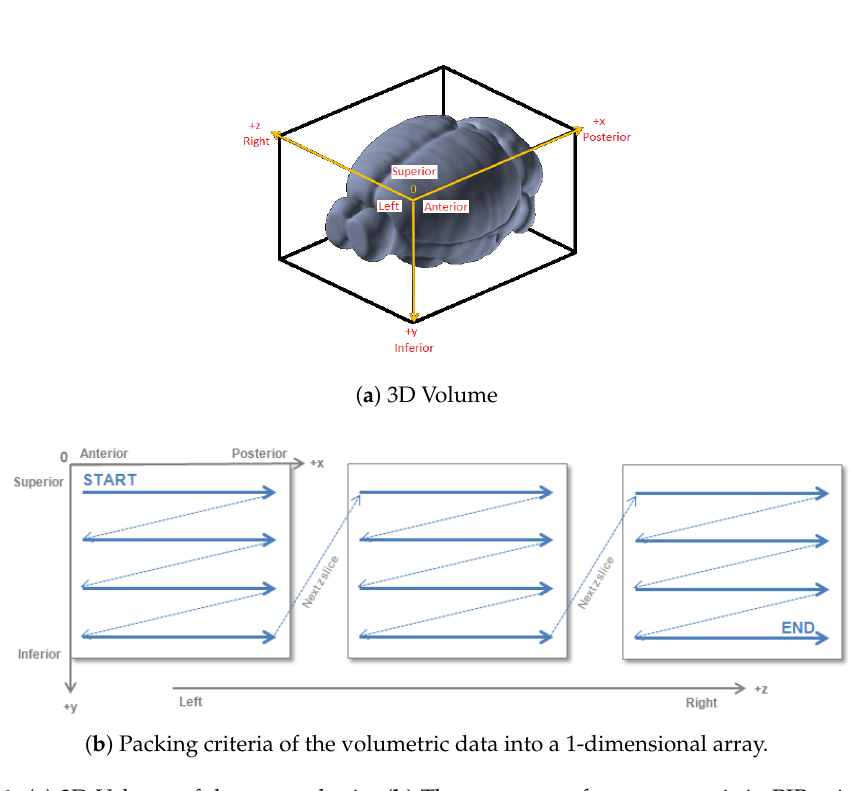
Figure 6. ( a ) 3D Volume of the mouse brain; ( b ) The common reference space is in PIR orientation where x axis = Anterior-to-Posterior, y axis = Superior-to-Inferior and z axis =